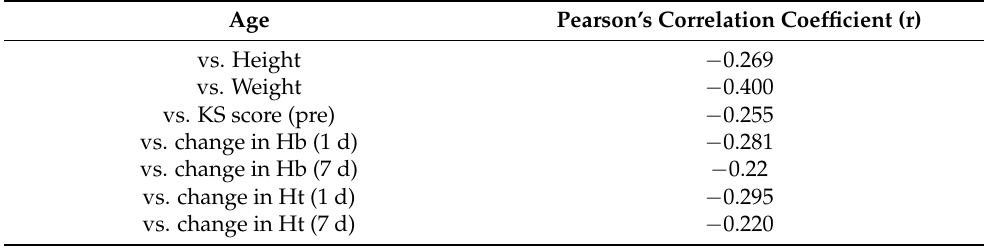
Table 4. Correlation with